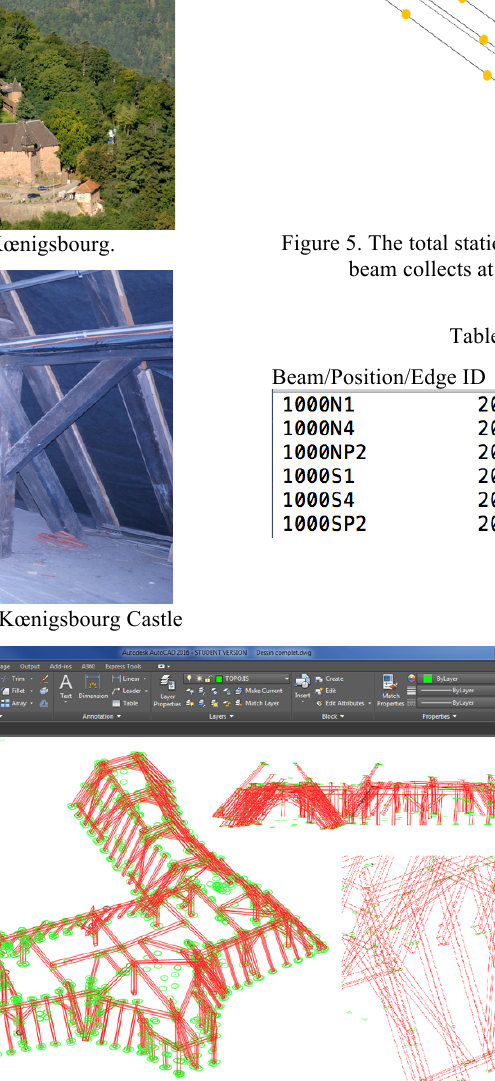
Figure 6. The green circles show the distribution of the original total station